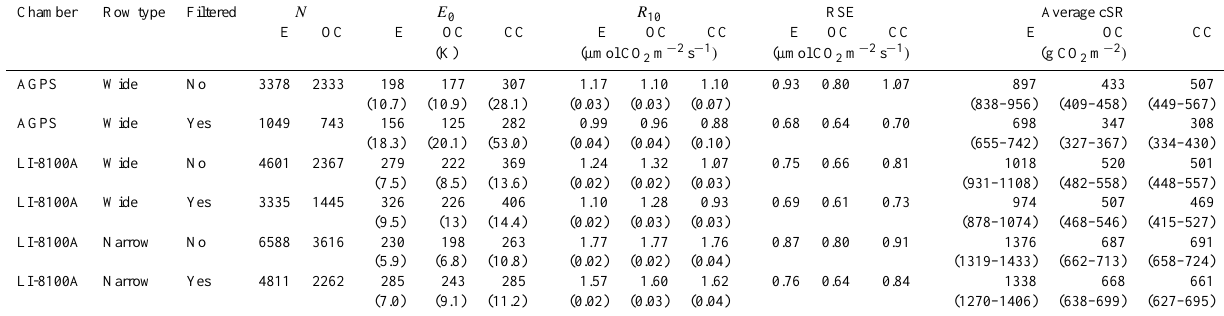
Table 3. Number of measurements ( N ), regression parameters ( E 0 is the temperature sensitivity coefficient; R 10 is the soil respiration rate at 10 ◦ C soil temperature at 5cm depth) and residual standard errors (RSEs) for the Lloyd and Taylor model fits presented in Fig. 6, and cumulated average soil respiration (cSR). Data are shown for the entire monitoring period (E, 15 April–31 August 2014), the open canopy phase (OC, 15 April–30 June 2014) and the closed canopy phase (CC, 1 July–31 August 2014) respectively. The standard errors for the regression parameters and the 95% confidence intervals for the average cSR respectively are shown in brackets.